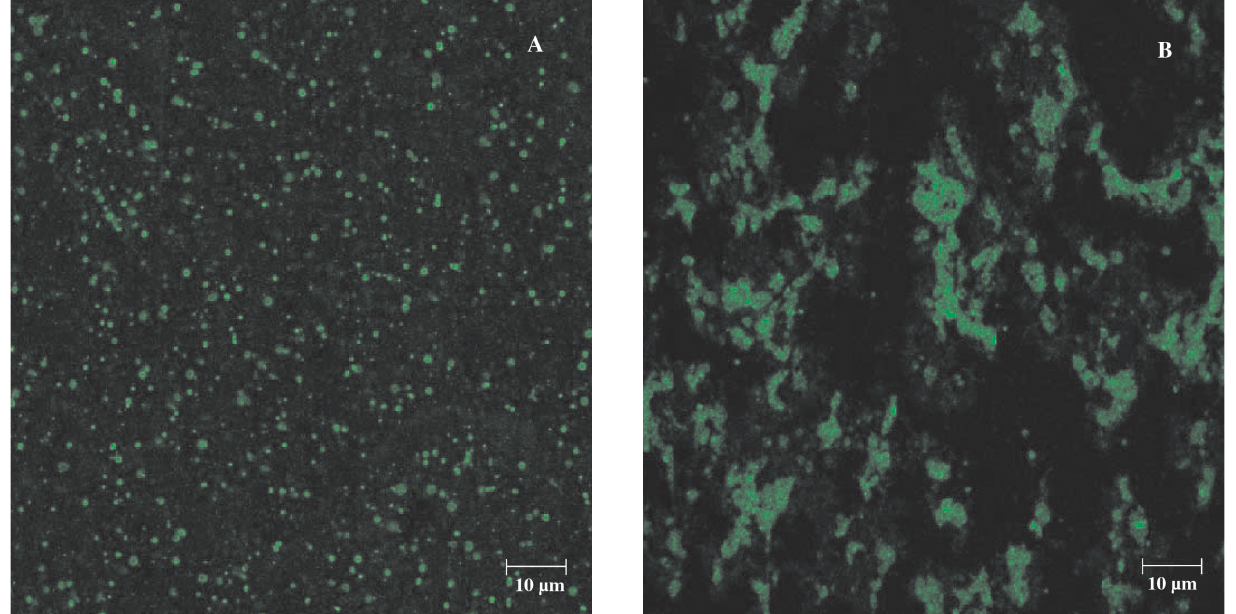
Figure 4. Confocal fluorescence images of N-NBD-PE-labeled PLFE large unilamellarvesicles in 50 mM KCl (A) without Ca 2+ (mean vesicle di- ameter = 499.4 nm) and (B) with 35.3 mM Ca 2+